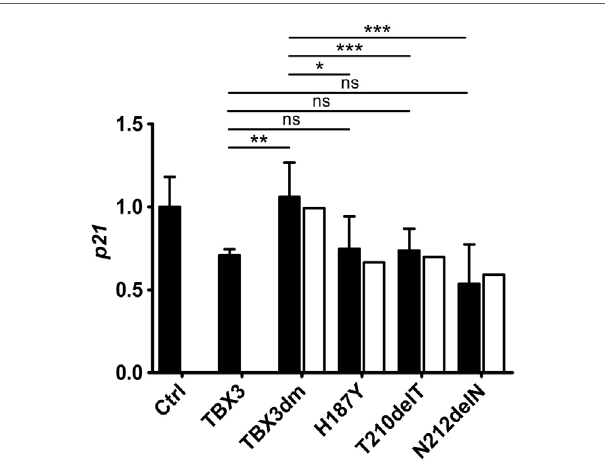
FigUre 5 | repression of the endogenous p21 gene by TBX3 and mutant derivatives . COS-7 cells were transfected with 50 ng of expression vector encoding TBX3 or its mutants (the empty vector was transfected in the control experiment). RNA was isolated and the level of p21 transcripts was determined by real-time qPCR. The p21 level is normalized to the control (1.0, black columns, error bars are SDs, n = 3 with three technical replicates each). To correct for differences in the amount of TBX protein, an adjustment was performed as described in Section “Materials and Methods” (white columns). Only TBX3dm differed significantly in p21 repression from normal TBX3, the three single mutants did